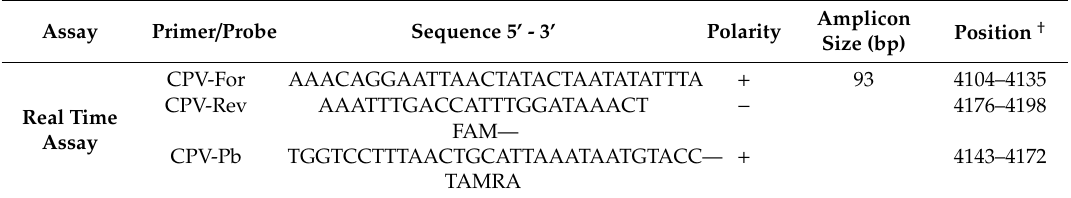
Table 1. Sequence and position of oligonucleotides used in the study [40]